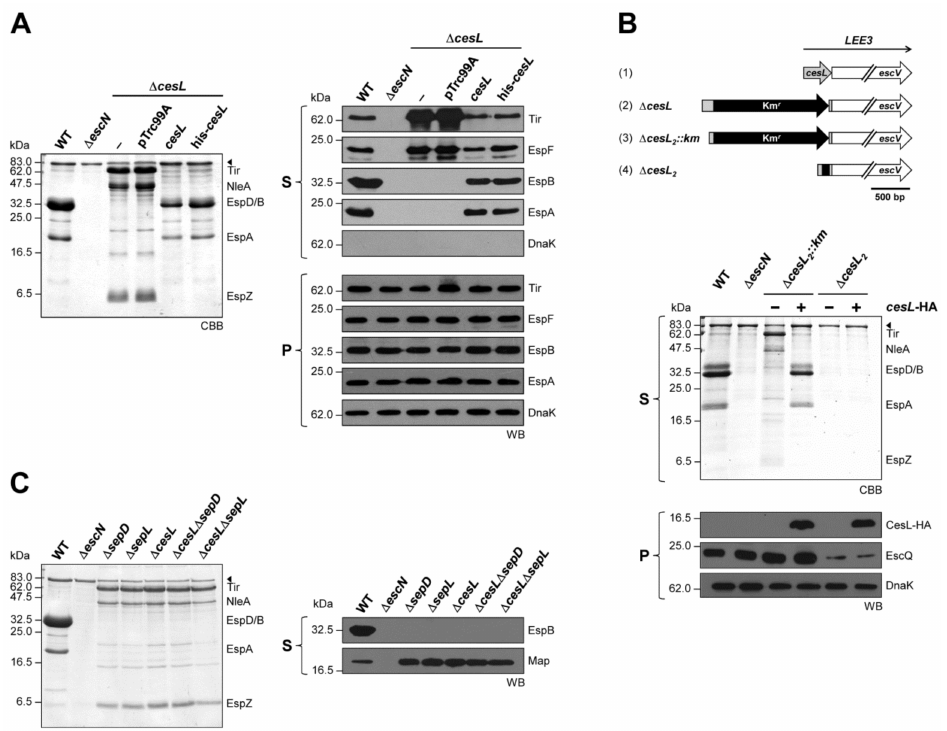
Figure 1. CesL protein is required for proper control of EPEC T3 secretion. ( A ) The EPEC wild-type strain (WT), ∆ escN mutant strain, and ∆ cesL mutant strain (-) carrying an empty vector (pTrc99A_FF4), plasmid pMTcL ( cesL ) producing untagged CesL or plasmid pMTHcL ( his-cesL ) producing His-CesL were grown under T3S inducing conditions and the secreted protein content was examined. Protein samples were resolved on SDS-PAGE and stained with Coomassie brilliant blue (CBB). Proteins corresponding to T3SS substrates or the autotransporter EspC (arrowhead) are indicated on the right. Secreted proteins (S) or whole-cell lysates (P) were analyzed by immunoblotting using antibodies against the indicated protein (WB). ( B ) In-frame deletion of the first gene in the LEE3 operon results in a polar effect. Upper panel. Genetic organization of (1) wild-type cesL gene, (2) ∆ cesL Km resistant mutant (3) equivalent CR orf12 deletion mutant in EPEC but with the kanamycin cassette ( ∆ cesL 2 ::km), (4) the latter mutant without the kanamycin cassette ( ∆ cesL 2 ). Lower panel. Secreted proteins (S) and whole-cell lysates (P) of EPEC WT, the isogenic mutant ∆ escN , and the cesL knock-out mutant with ( ∆ cesL 2 ::km) or without ( ∆ cesL 2 ) the kanamycin resistance cassette, and carrying (+) or not (-) pMATcL2HA plasmid expressing CesL-HA. Protein samples were analyzed by CBB-stained SDS- PAGE or immunoblotting with antibodies against the HA tag, the LEE3-encoded protein EscQ or the intracellular housekeeping chaperone DnaK. EspC is indicated with an arrowhead in CBB. ( C ) The EPEC ∆ cesL mutant displays the same secretion phenotype as the ∆ sepD and ∆ sepL mutants. Protein secretion profile of EPEC WT, ∆ escN , ∆ sepD , ∆ sepL , ∆ cesL and the ∆ cesL ∆ sepD and ∆ cesL ∆ sepL double mutants was analyzed by CBB-stained SDS-PAGE (left panel) or by immunoblotting using anti-EspB and anti-Map antibodies (WB, right panel). EspC is indicated with an arrowhead in